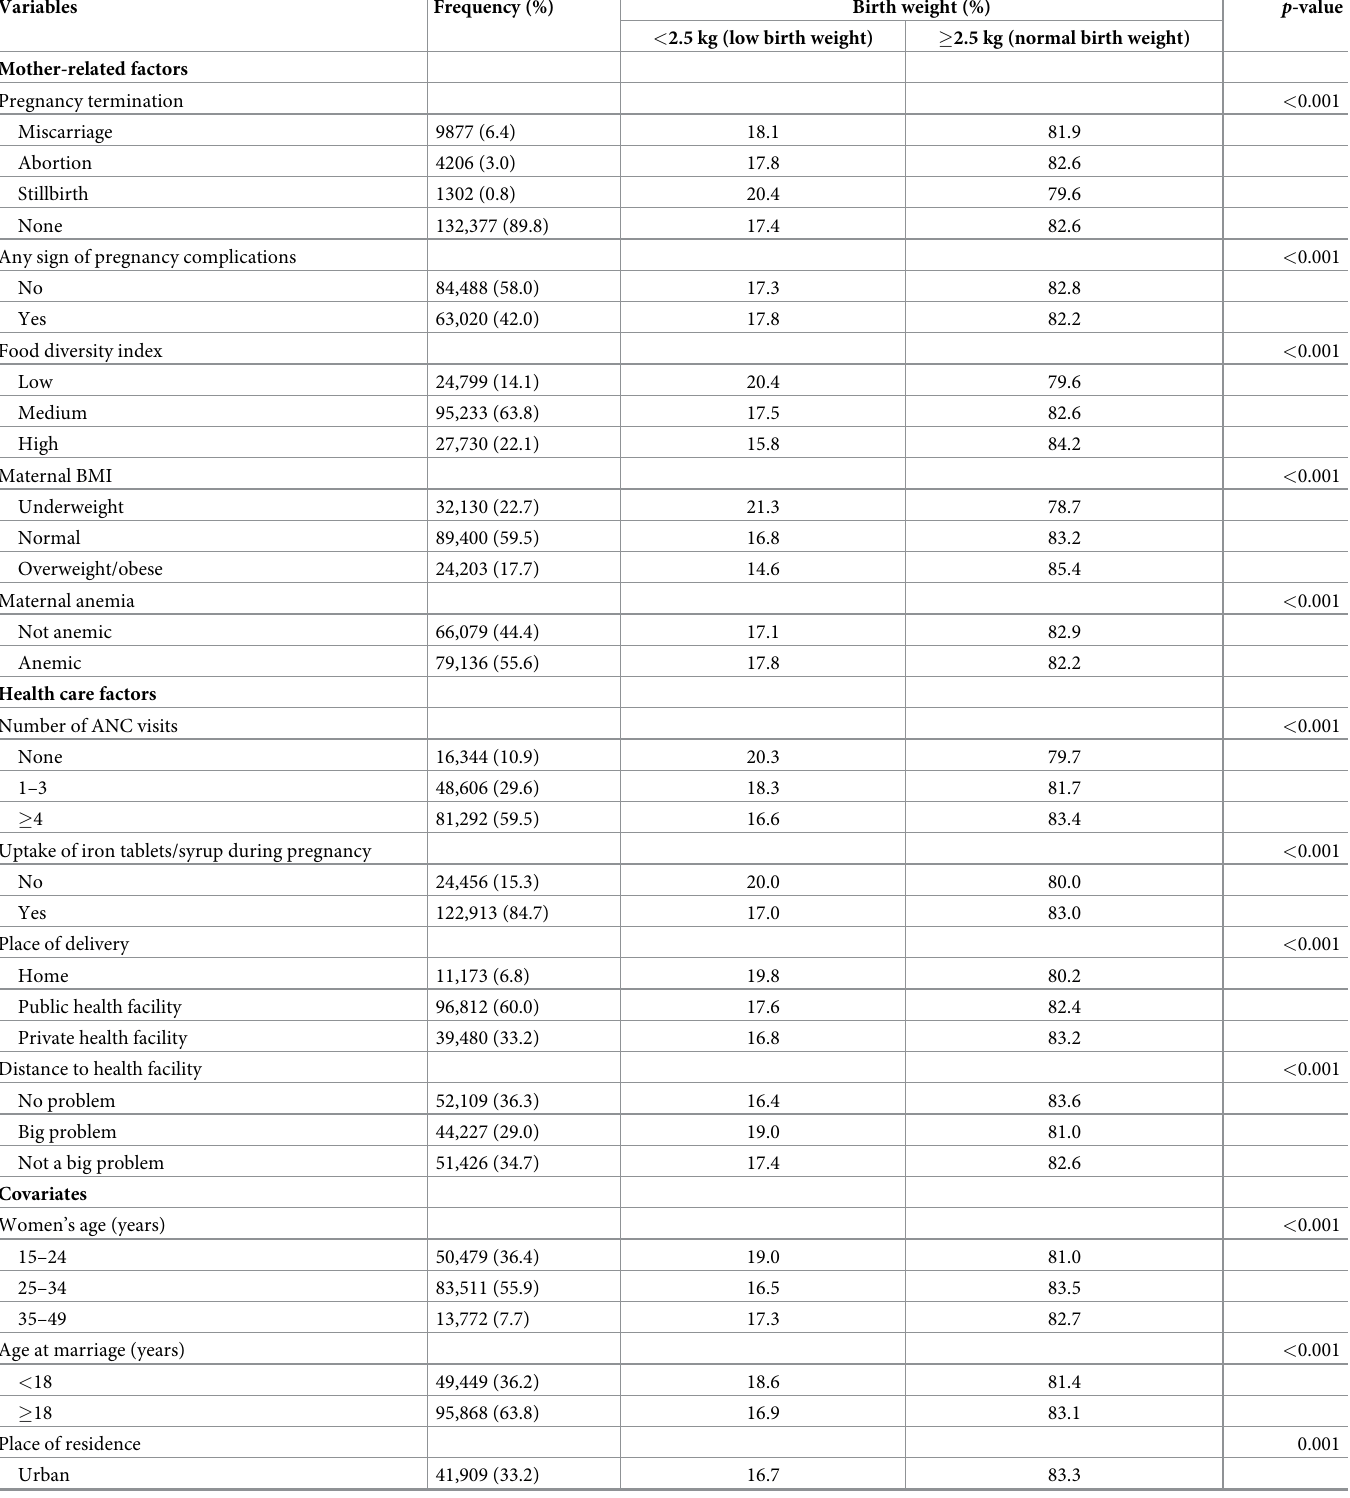
Table 1. Respondent’s characteristics and birth weight of children by explanatory variables, NFHS-4 (n =